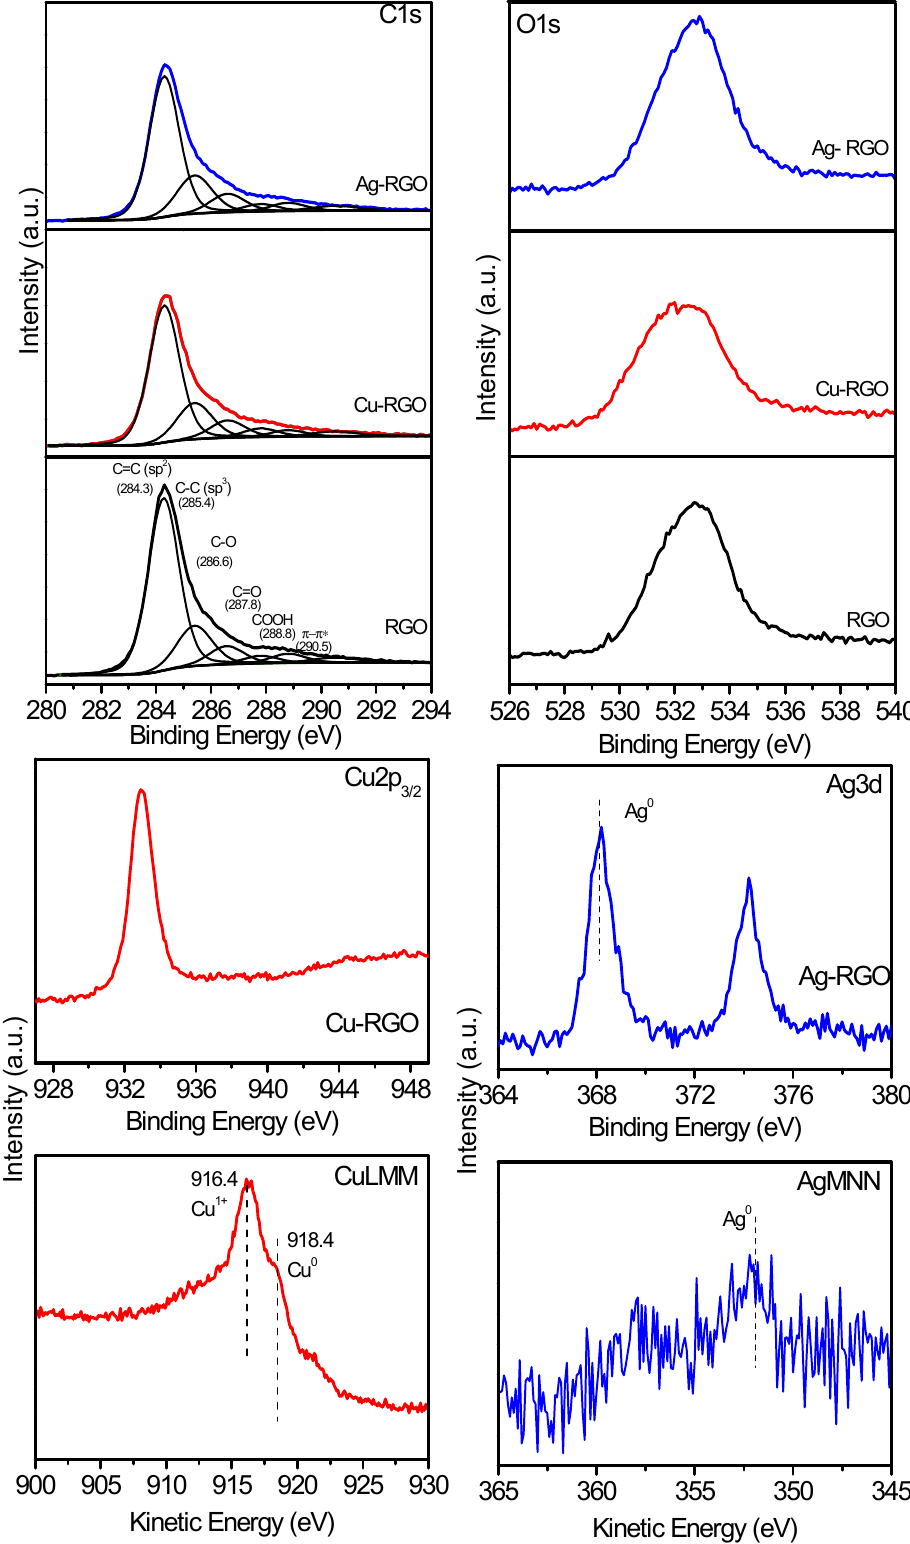
Figure 7. XPS spectra of C 1s, O 1s, Cu 2p 3/2 , Ag 3d, Cu LMM and Ag MNN for RGO and the composites Cu–RGO and Ag–RGO.